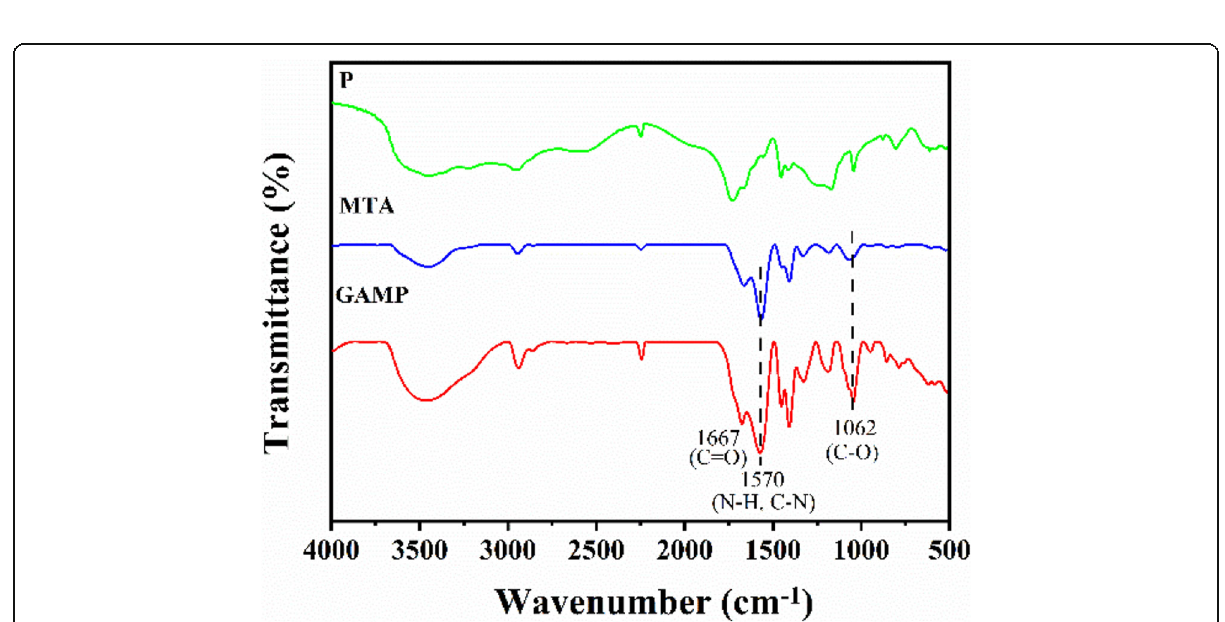
Fig. 4 FT-IR spectra of the P, GAMP and